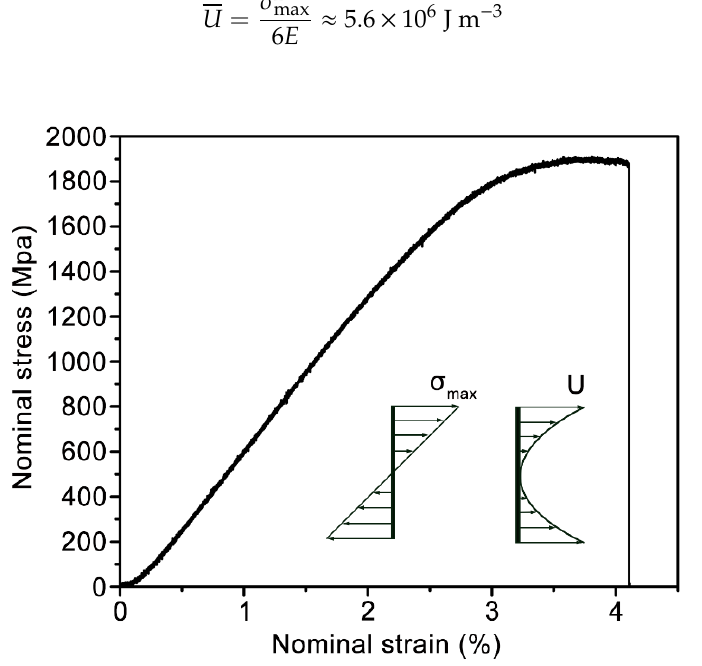
Figure 4. The nominal stress-strain curve of the Vit.1 strip under 3-point bending.